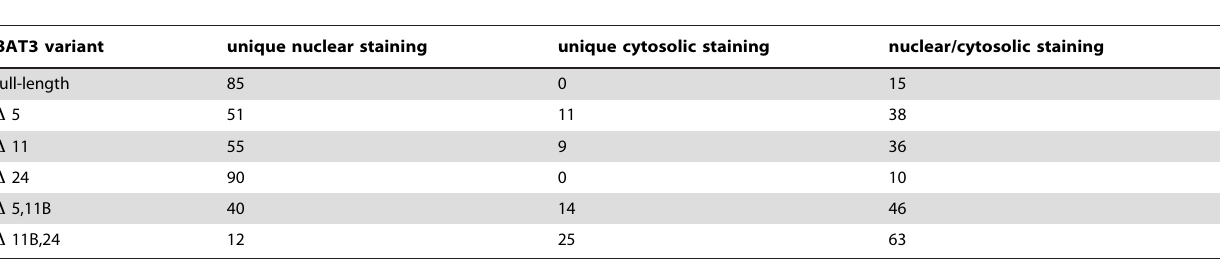
Table 4. Subcellular localization of the BAT3 variants in % of transfected HeLa cells.